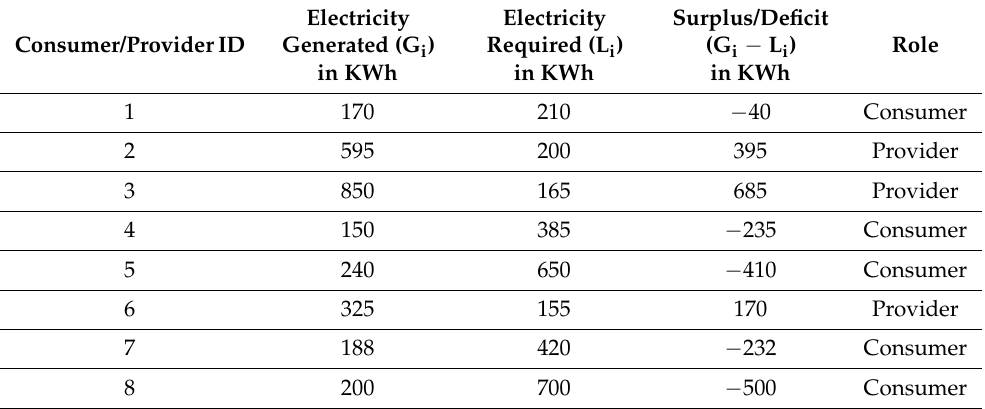
Table 3. System data for